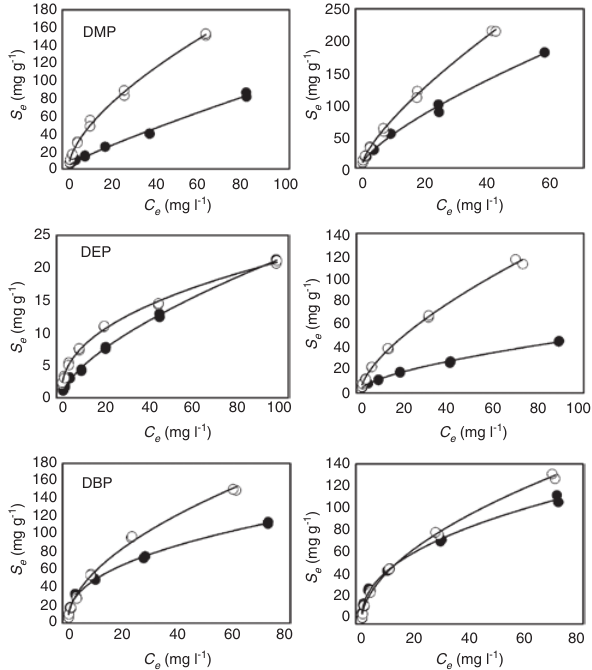
Figure 4: Adsorption of dimethyl phthalate (DMP), diethyl phthalate (DEP) and dibutyl phthalate (DBP) on biochars and oxidized bio- chars, as a function of oxidation (300 ° C left and 500 ° C right hand). Open and closed symbols ( ○ , ● ) represent original and oxidized biochars,